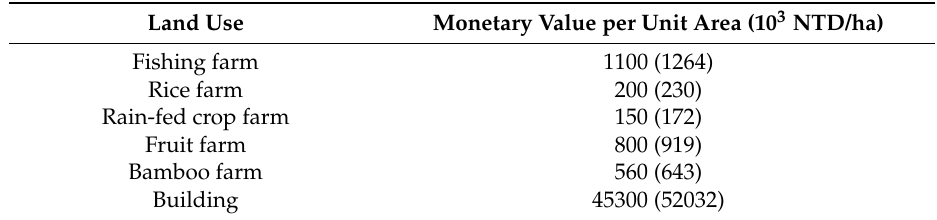
Table 2. Value of output for various land use per unit area [15].